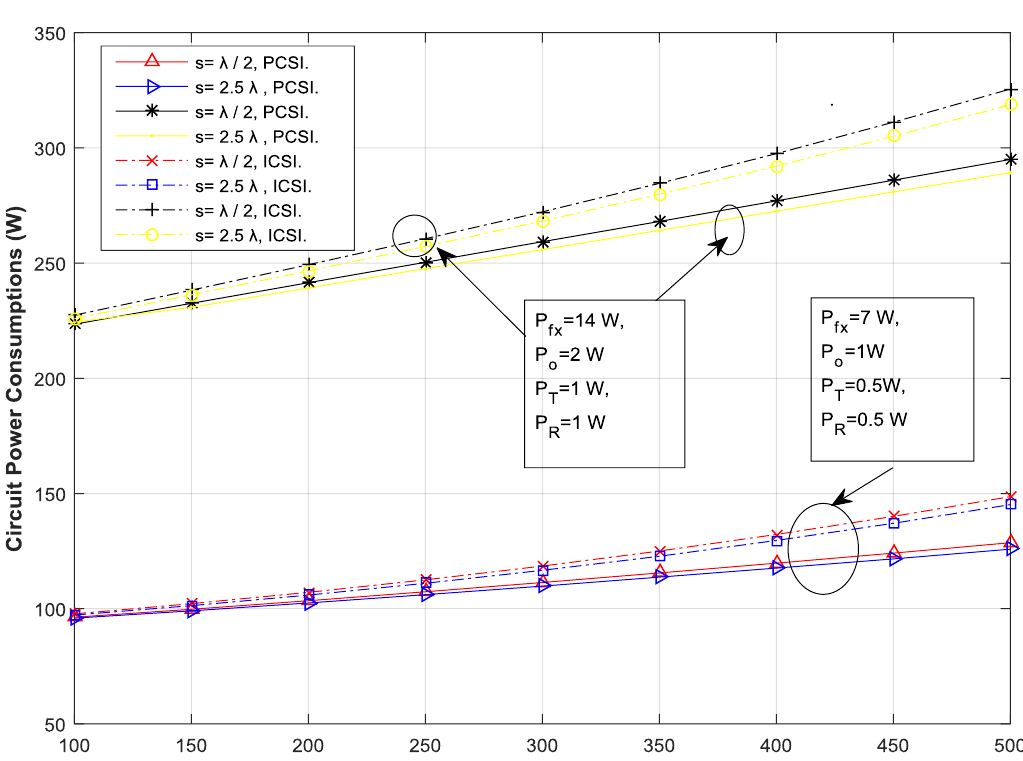
Figure 9. Circuit Power Consumption.